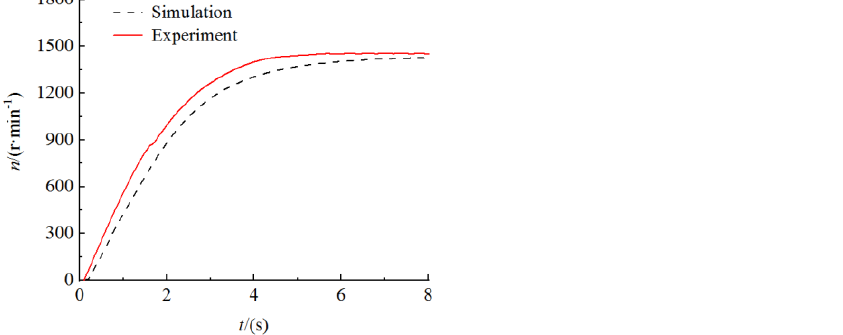
Figure 6. Comparison of rotational speed during the start-up process between simulated and experimental results at α g = 0.15.